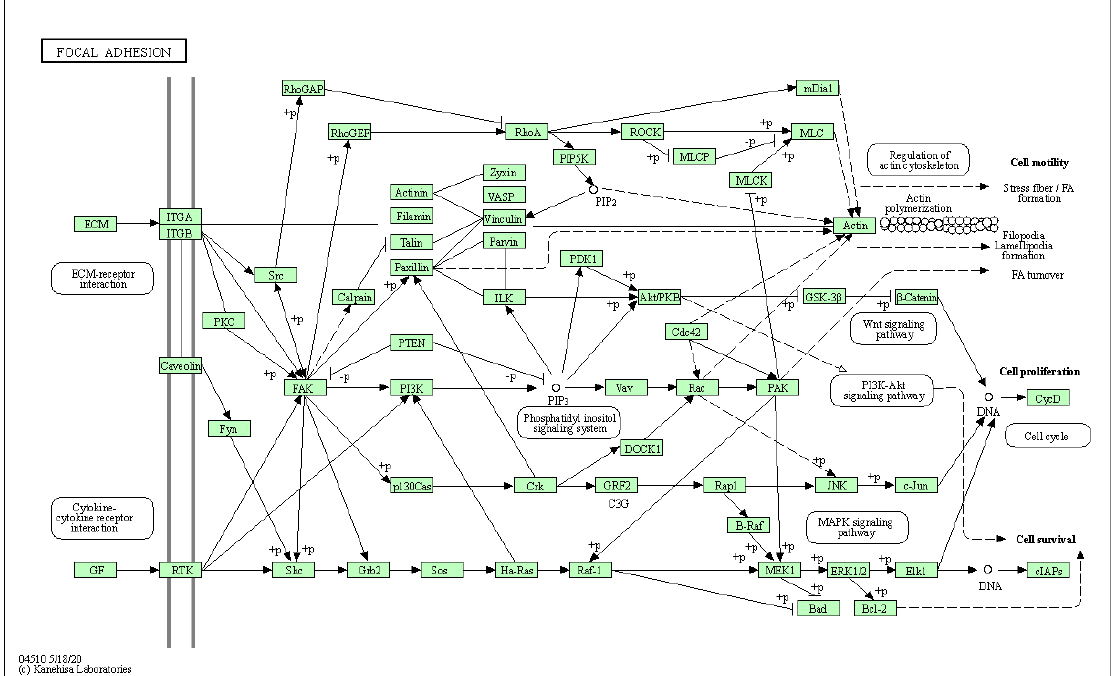
Figure A4. Focal adhesion signaling pathway, KEGG pathway. KEGG, Kyoto Encyclopedia of Genes and Genomes. Copyright permission obtained.